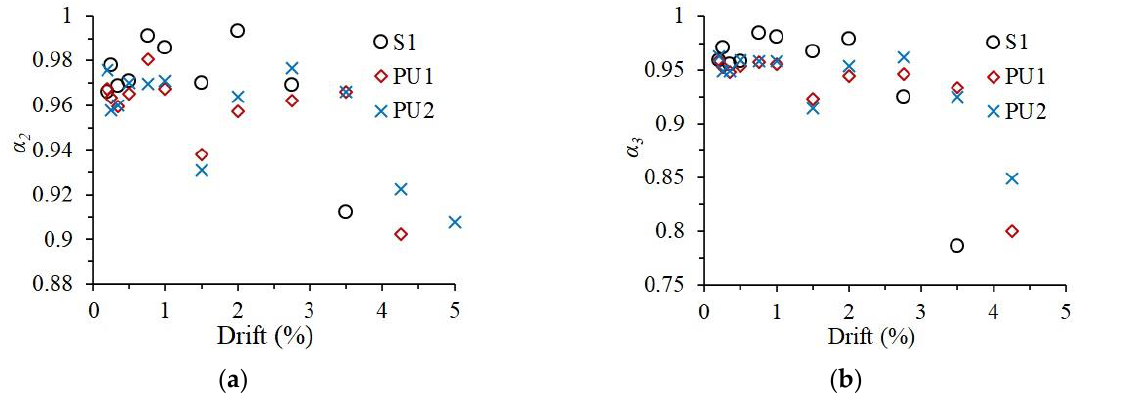
Figure 9. Strength coefficient of the three specimens. ( a ) α 2 , ( b ) α 3 .